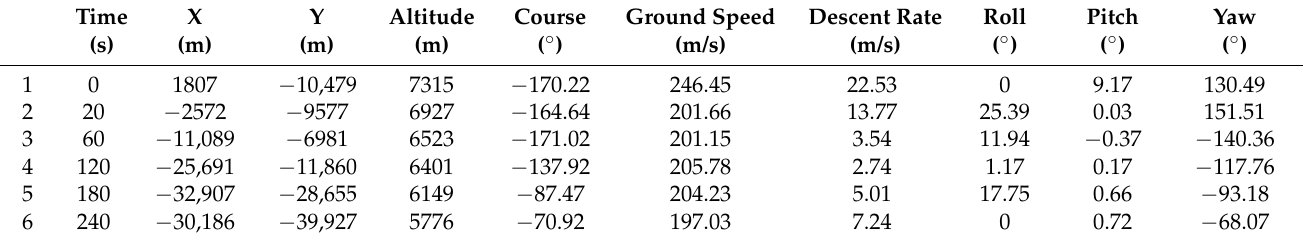
Table 2. Trajectory data for spoofed ghost aircraft.